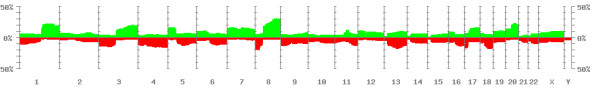
Overall imbalance pattern from all cases. For each chromosomal band (862 bands resolution) the percentage of cases with gains (green, upward) and losses (red, downward) is indicated.